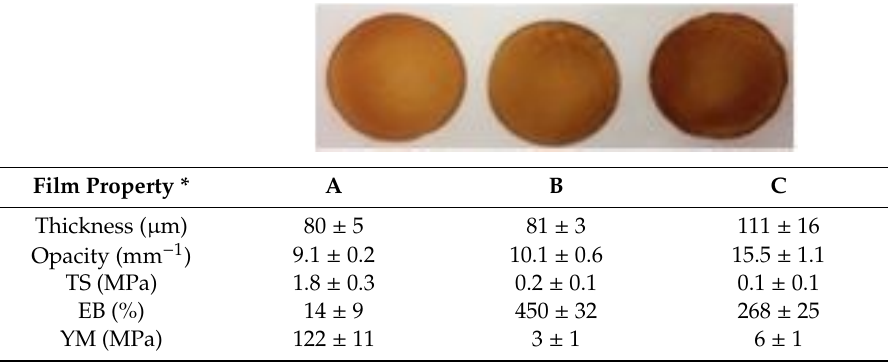
Table 1. Images and properties of films obtained at different pH values (A, pH 3.0; B, pH 3.5; C, pH 4.0) with 800 mg of dialyzed homopolypeptide preparation. Experimental details are given in the text.